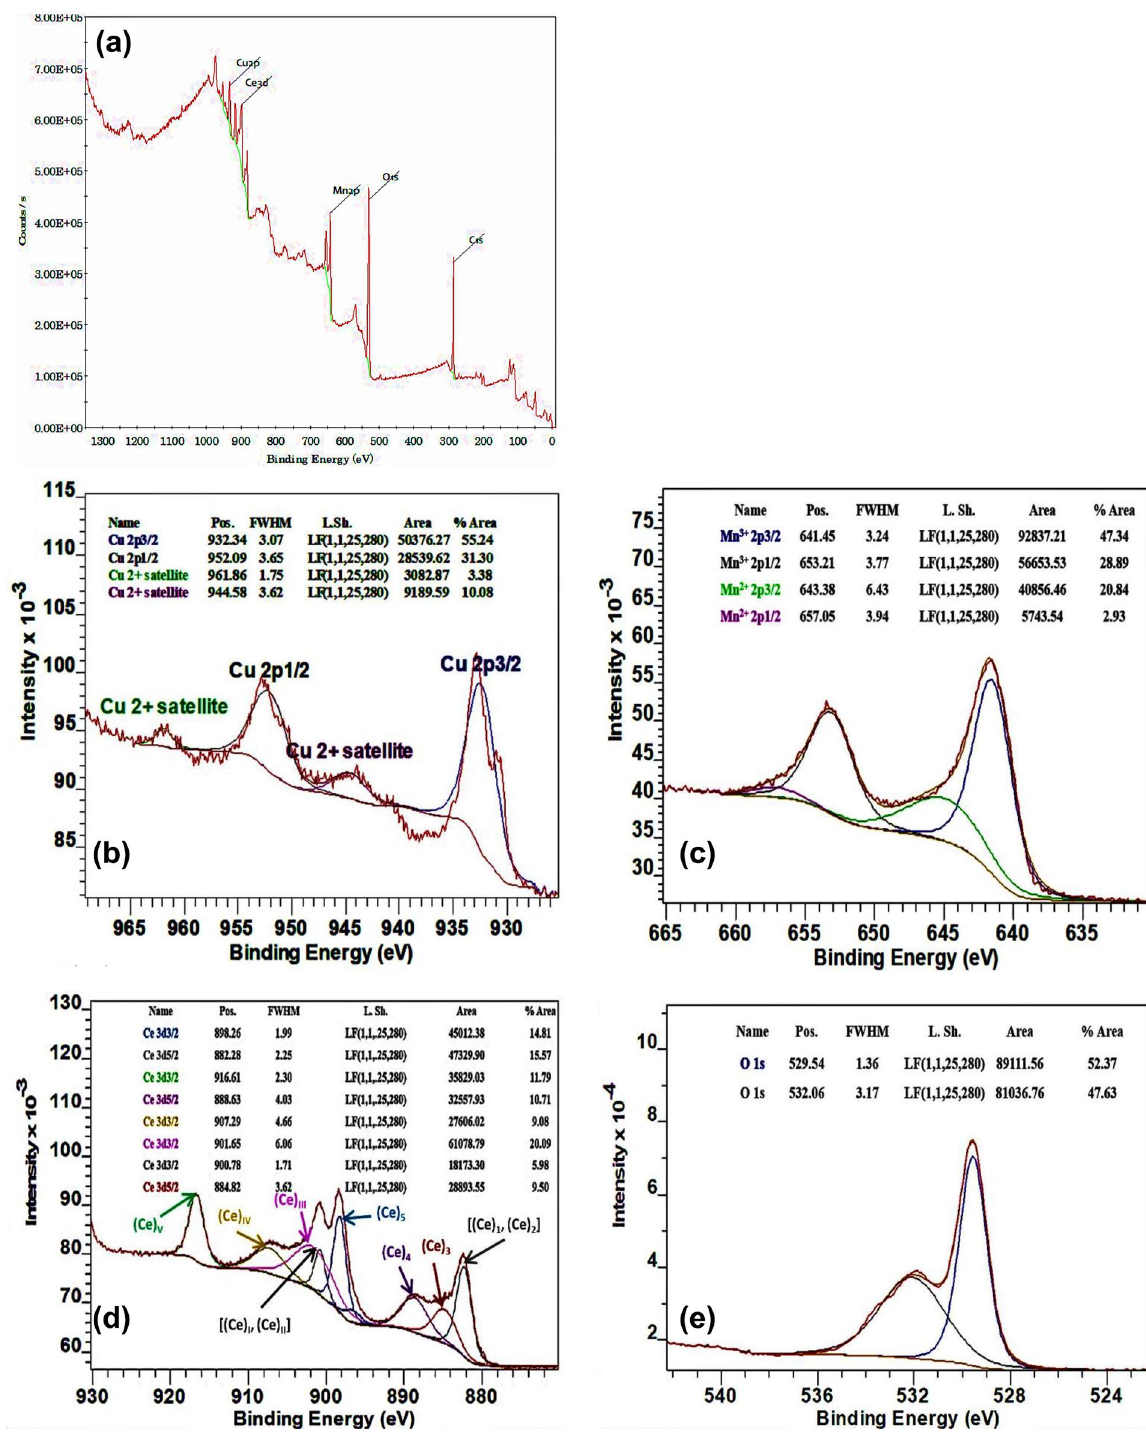
Figure 8. ( a ) XPS survey spectrum of CuO/Mn 3 O 4 /CeO 2 heterostructure, XPS spectrum of ( b ) Cu2p, ( c ) Mn2p, ( d ) Ce3d, and ( e ) O1s for electronic state investigation in CuO/Mn 3 O 4 /CeO 2